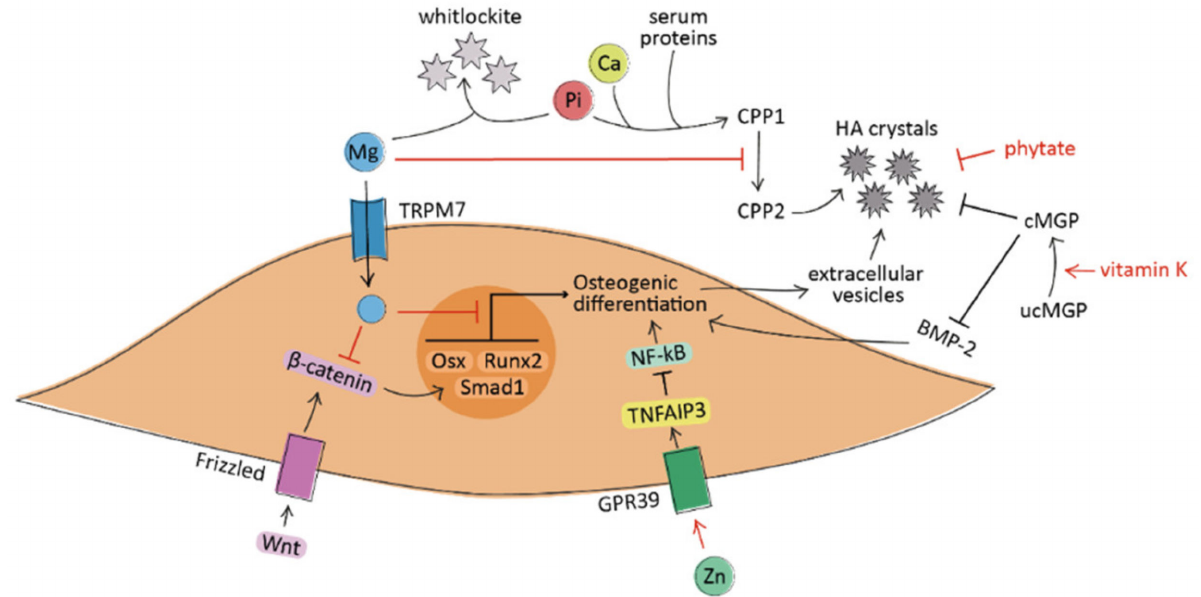
Figure 1. A simplified schematic representation of the processes under investigation leading to the osteogenic differentiation of VSMCs in vascular calcification. Magnesium (Mg) acts at the extracellular level by preventing the maturation of calciprotein particles (CPPs) and by forming whitlockite crystals with phosphate ions (Pi). At the intracellular level, Mg decreases the expression of osteogenic genes (such as Osterix, Smad1, and Runx2) and inhibits pro-calcific pathways (including Wnt/ β -catenin). Zinc (Zn) induces the suppression of NF- κ B through the activation of the GPR39/TNFAIP3 signaling pathway. Vitamin K promotes the carboxylation and activation of the matrix Gla protein (MGP), which avoids the formation of hydroxyapatite (HA) crystals and prevents the pro-calcific action of BMP-2. Phytate acts as crystallization inhibitor by binding to HA crystals. The regular arrow denote “activation”, and the T-shaped arrow stands for